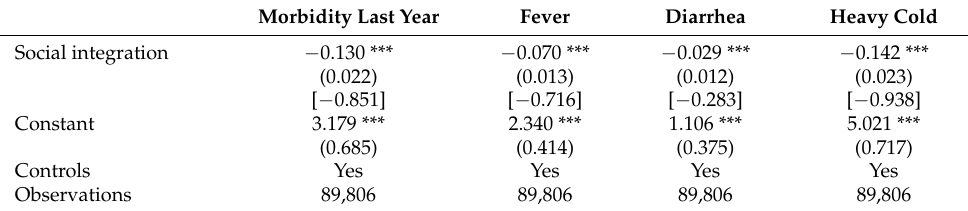
Table 3. Robustness checks: alternative measures of health. Morbidity Last Year Fever Diarrhea Social